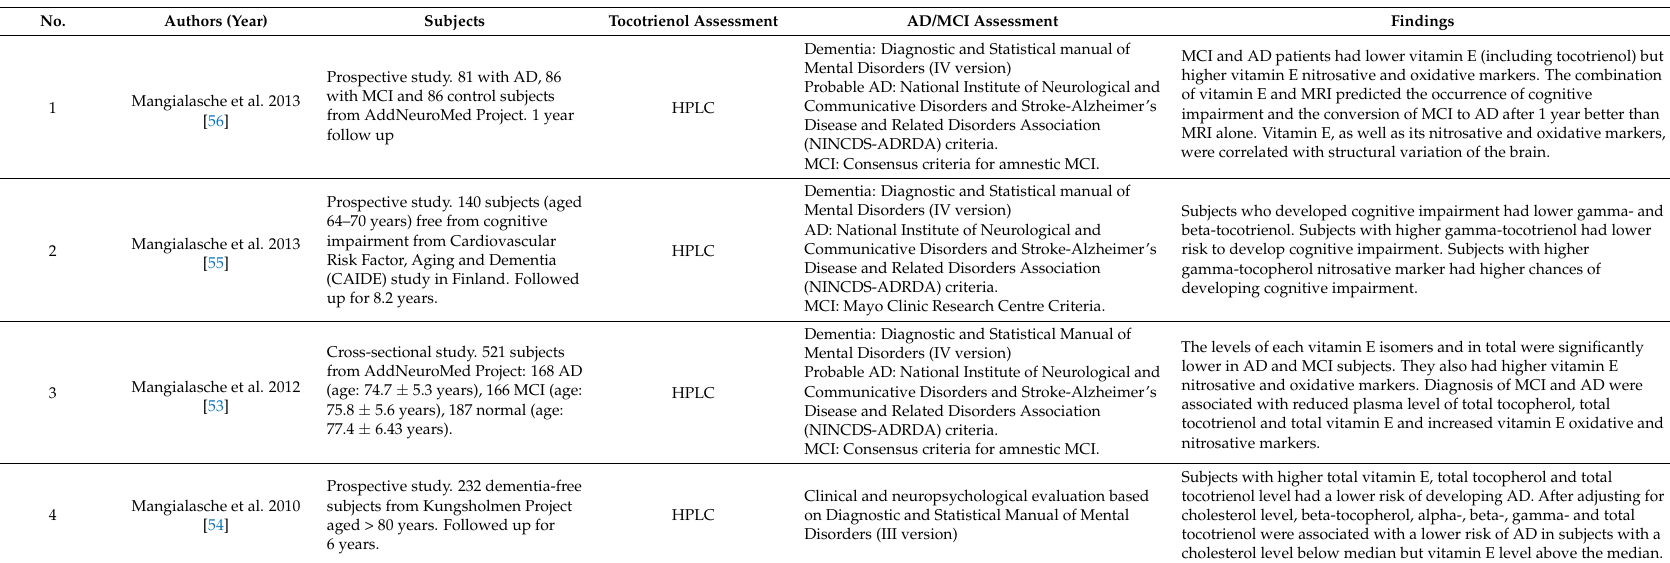
Table 1. Epidemiology studies on the relationship between tocotrienol and Alzheimer